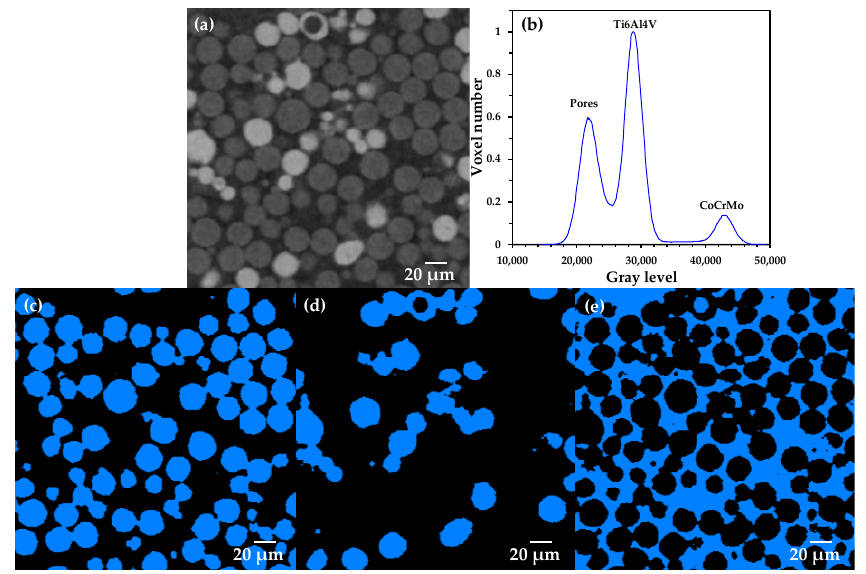
Figure 1. 2D virtual slice of Ti6Al4V/20CoCrMo composite ( a , b ) histogram of voxel gray levels of the complete 3D image. ( c – e ) are 2D virtual slices of the binary images of the three phases, separated by selecting the gray level in the histogram corresponding to the Ti6Al4V, CoCrMo and pores, re- spectively.